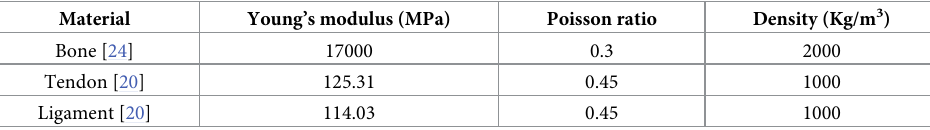
Table 1. The preset values of the material parameters.